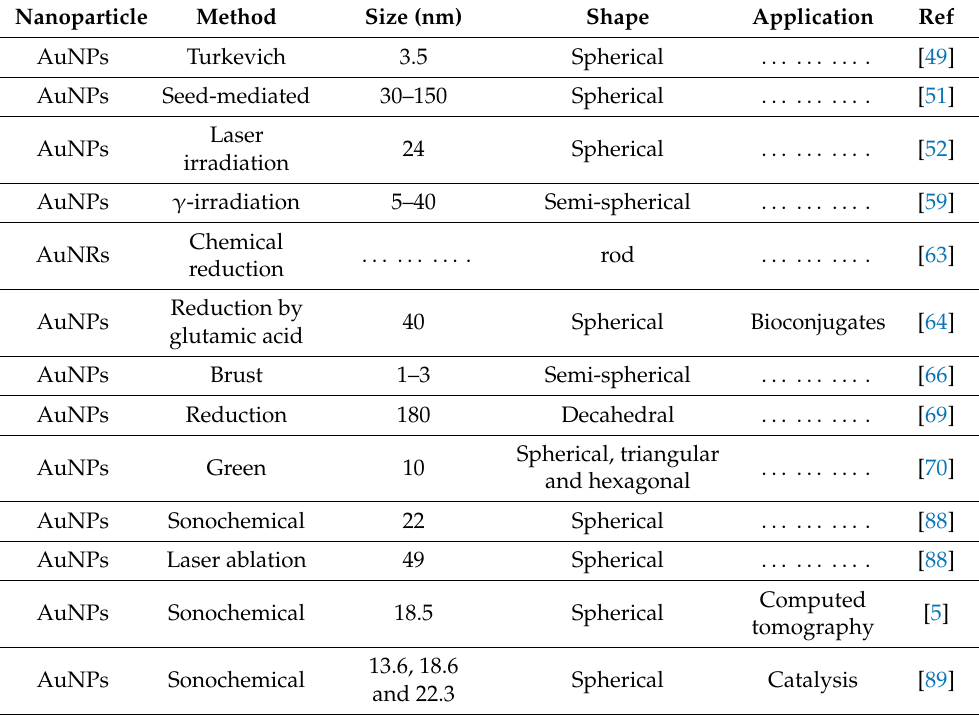
Table 1. Different methods of synthesizing